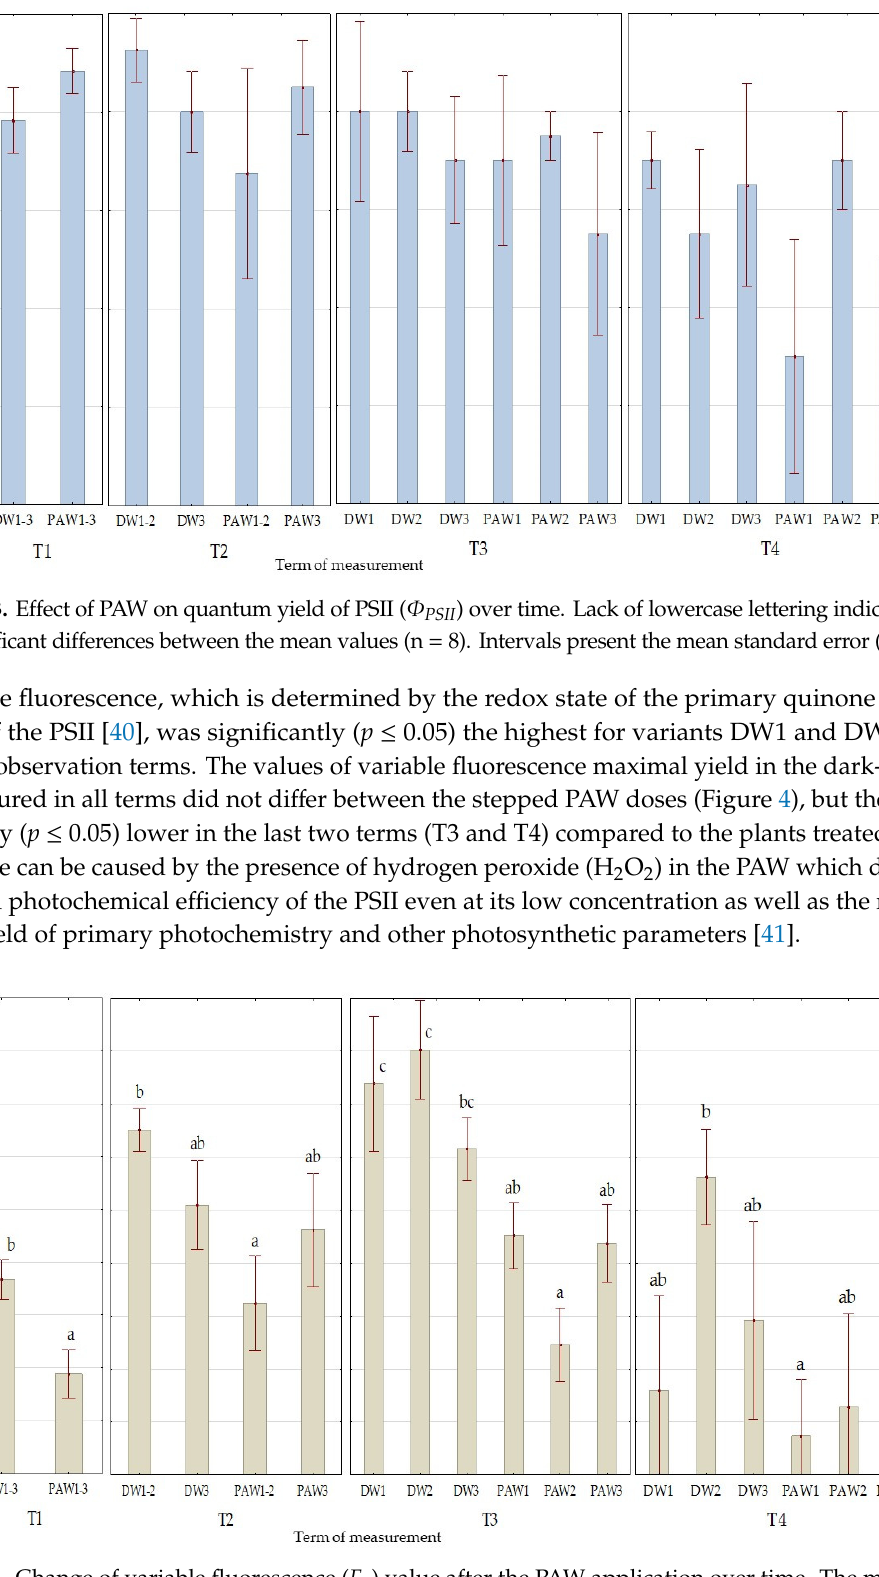
Figure 4. Change of variable fluorescence ( F v ) value after the PAW application over time. The mean values (n = 8) sharing the same lowercase letter are not significantly different from each other ( p ≤ 0.05) according to the LSD test (each term was evaluated separately). Intervals present the mean standard error (SE).